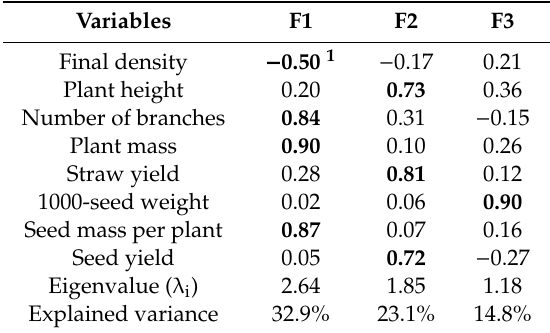
Table 2. Factor loads in factor analysis with varimax rotation.